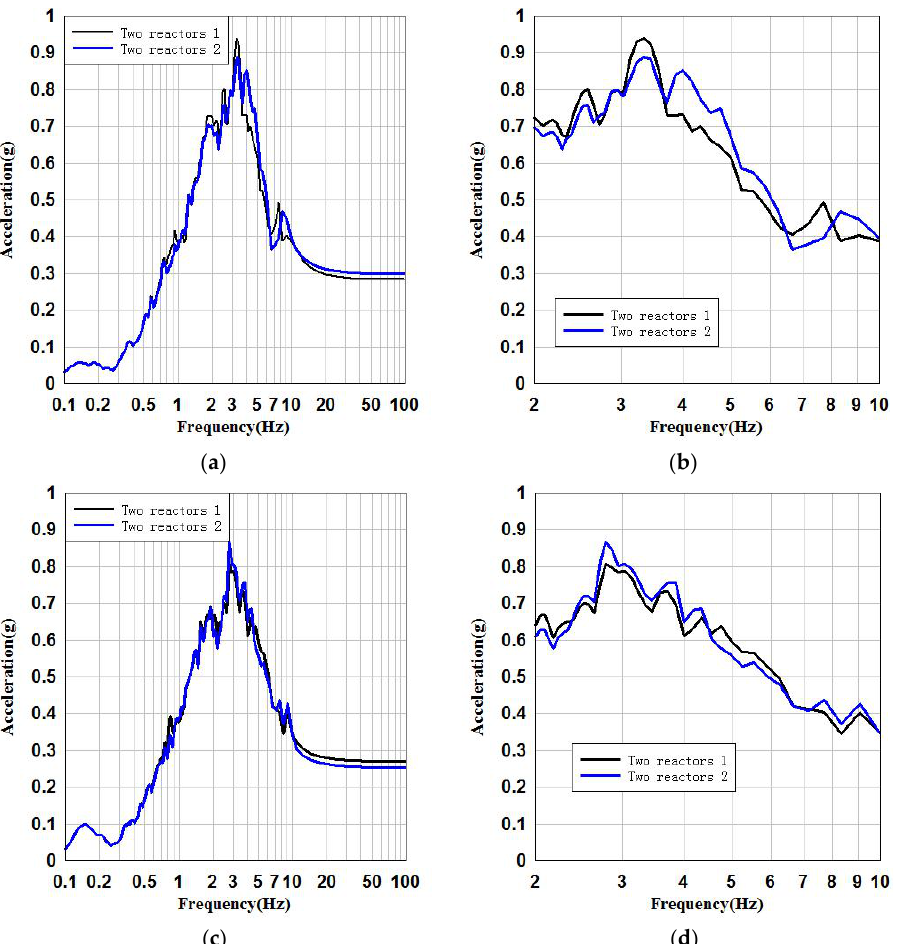
( d ) Figure 5. FRS of the raft foundation reference point in x and y directions. ( a ) FRS of the raft foun- dation in the x direction. ( b ) FRS of the raft foundation in the x direction (2–10 Hz). ( c ) FRS of the raft foundation in the y direction. ( d ) FRS of the raft foundation in the y direction (2–10 Hz).